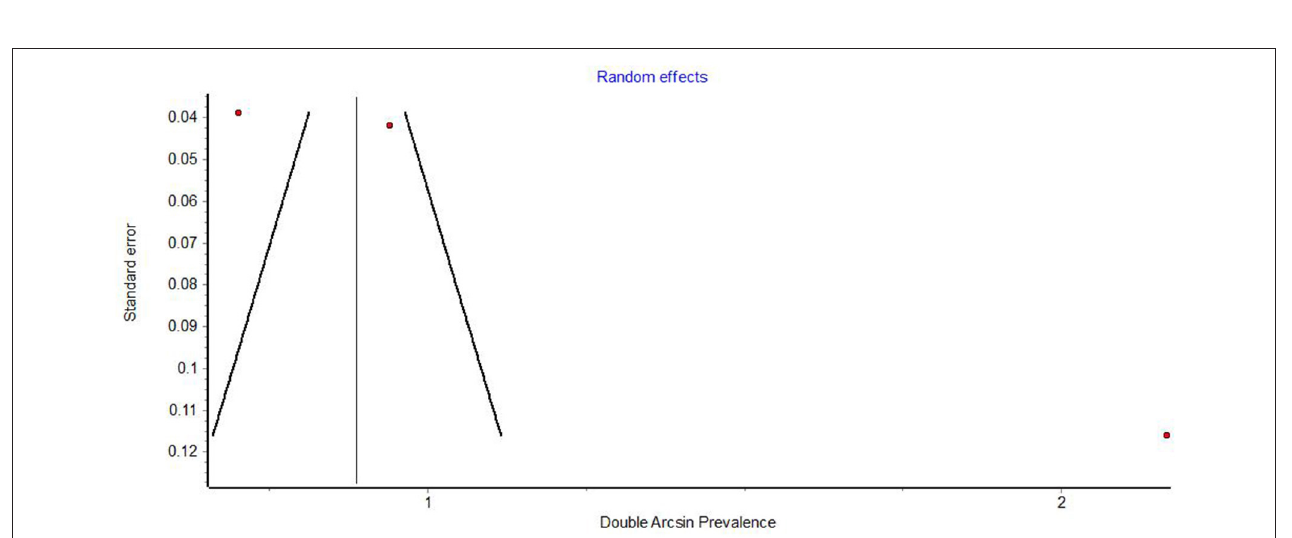
Frontiers in Medicine |